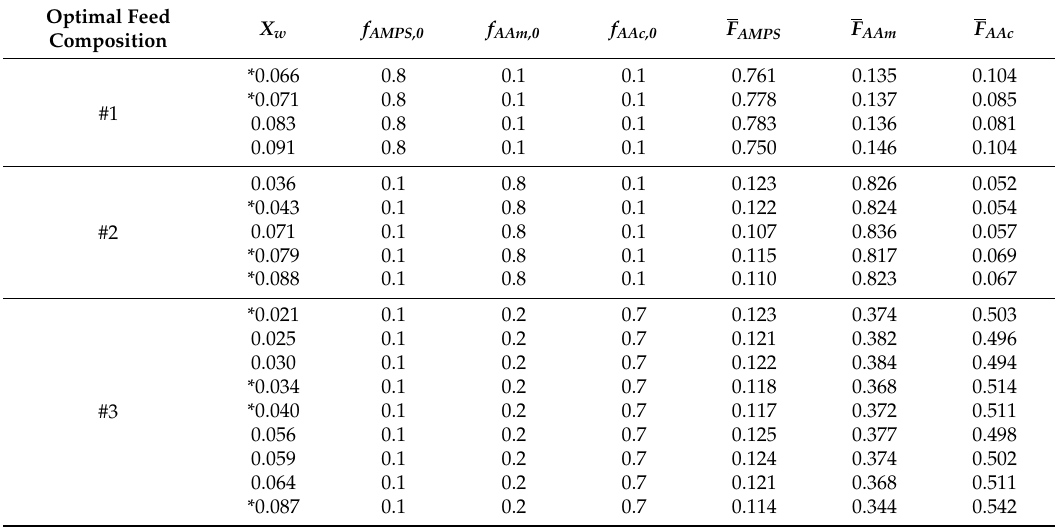
Table 2. Experimental data for AMPS/AAm/AAc terpolymerization; low conversion. Optimal Feed